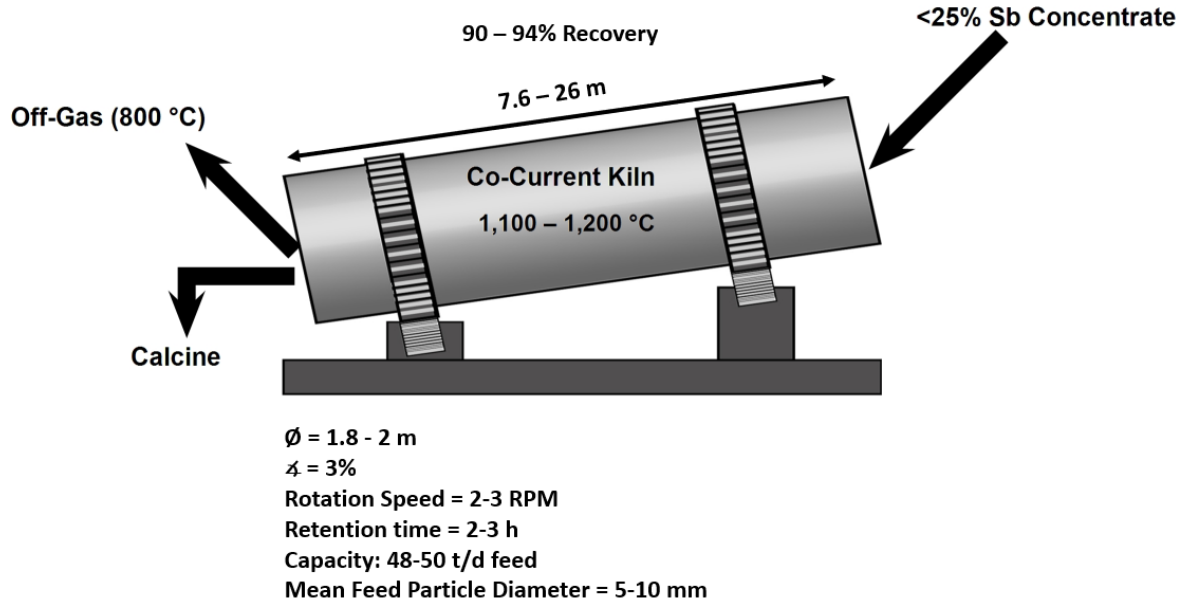
Figure 4. Schematic visualization of conventional volatilization roasting in a co-current kiln (adapted from [2]).